Question: What visual encoding does this figure use to show its data?
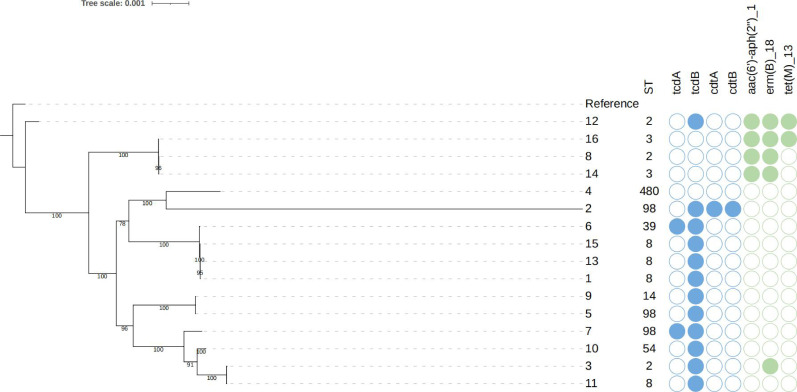
Answer: heatmap